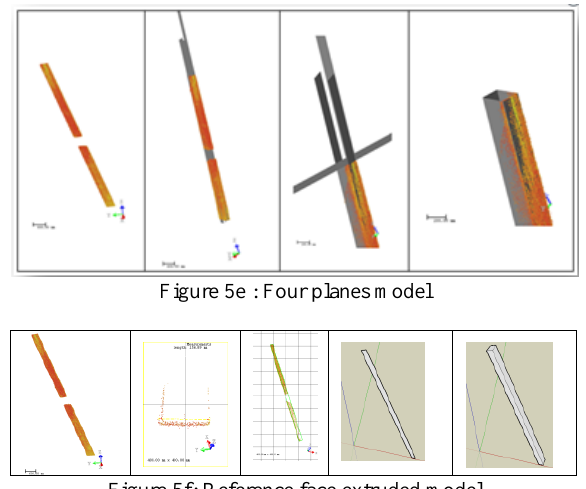
Figure 5f: Reference face extruded model